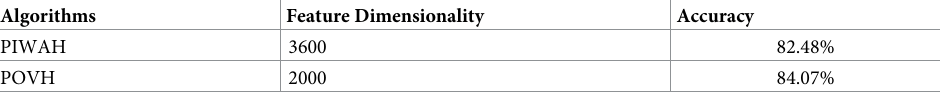
Table 3. Classification accuracy and size of feature vector comparison while using RSSCN image dataset.